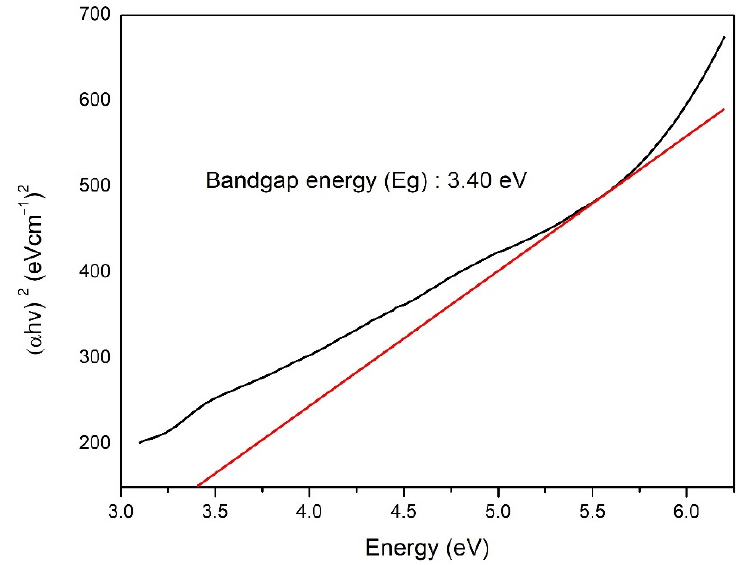
Figure 5. TiO 2 nanoparticle band gap analysis curve with Tauc method.